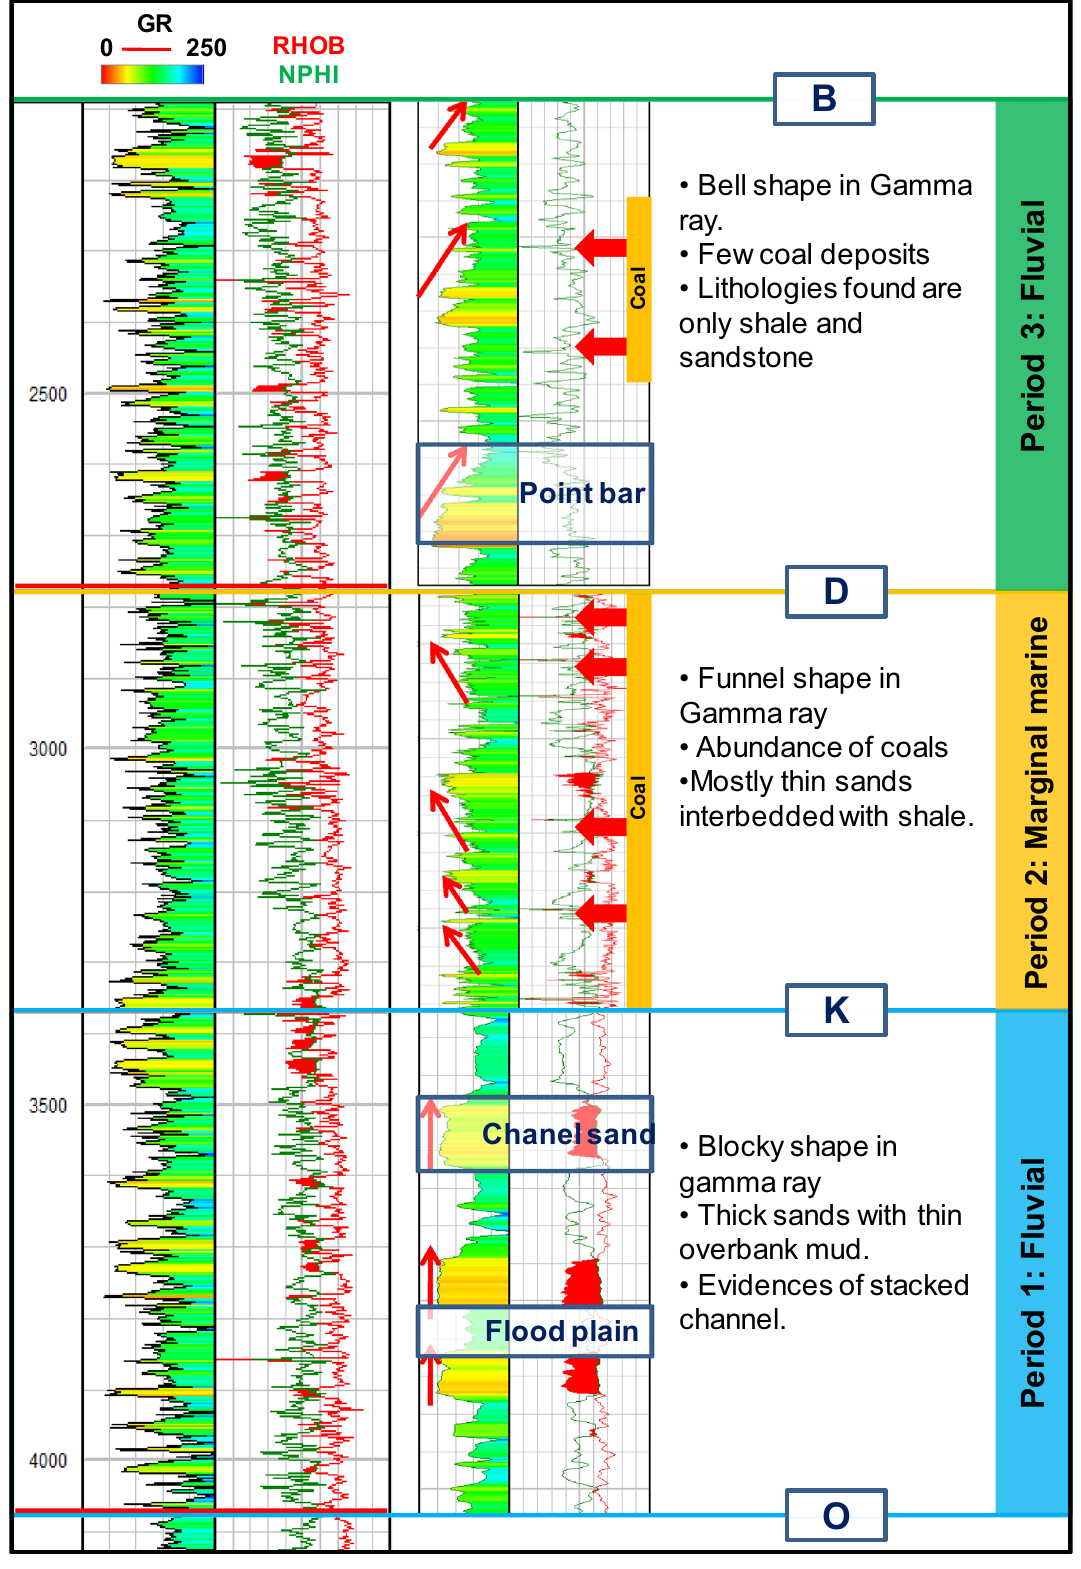
Fig. 4 Interpreted depositional environments at different periods. Three major depositional environments are interpreted based on log